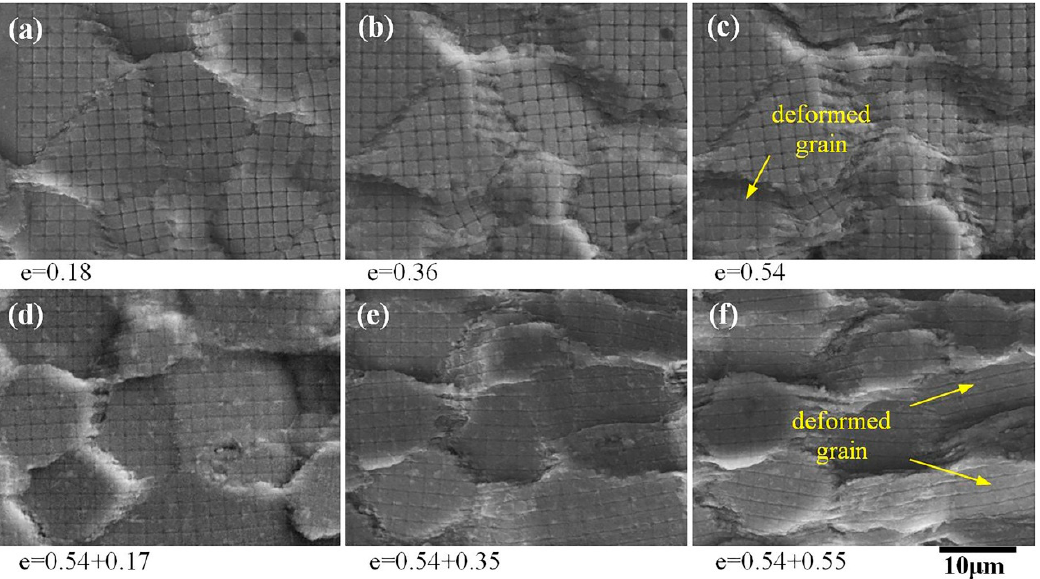
Figure 8. SEM secondary electron images of the local fine grids after superplastic deformation at 490 °C and 2 × 10 − 4 s − 1 .